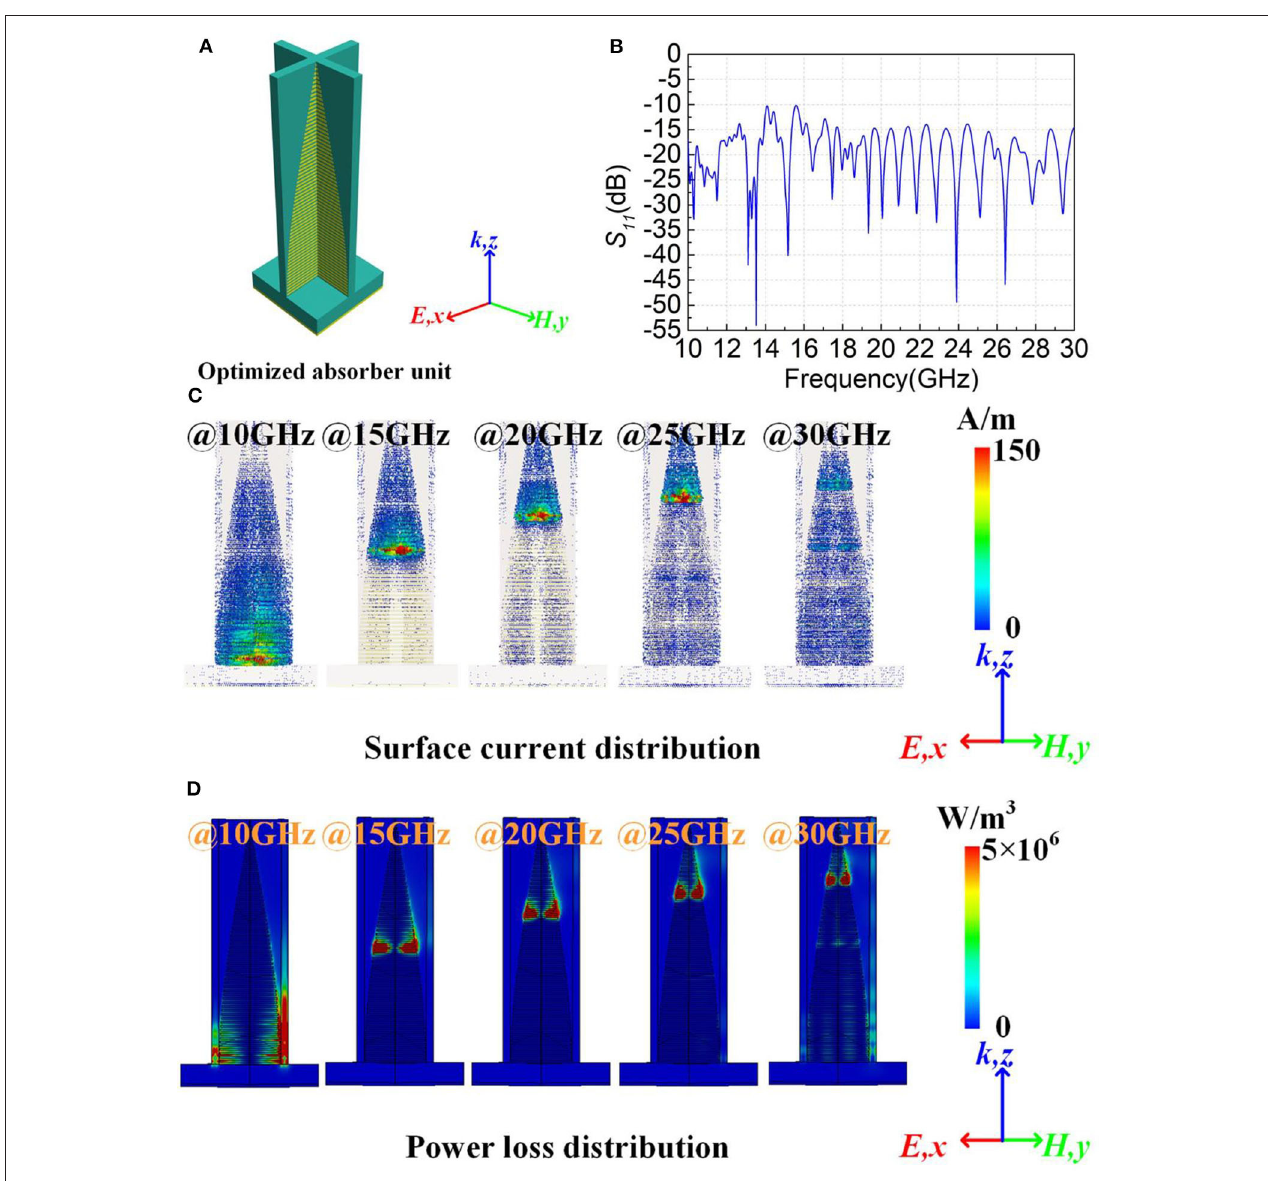
FIGURE 5 | Electromagnetic response of the APS. (A) The model of optimized APS, (B) the simulation result of this model, (C) surface current distributions of the parallel straight strips in 10, 15, 20, 25, and 30 GHz, and (D) power loss distributions of the parallel straight strips in 10, 15, 20, 25, and 30 GHz.